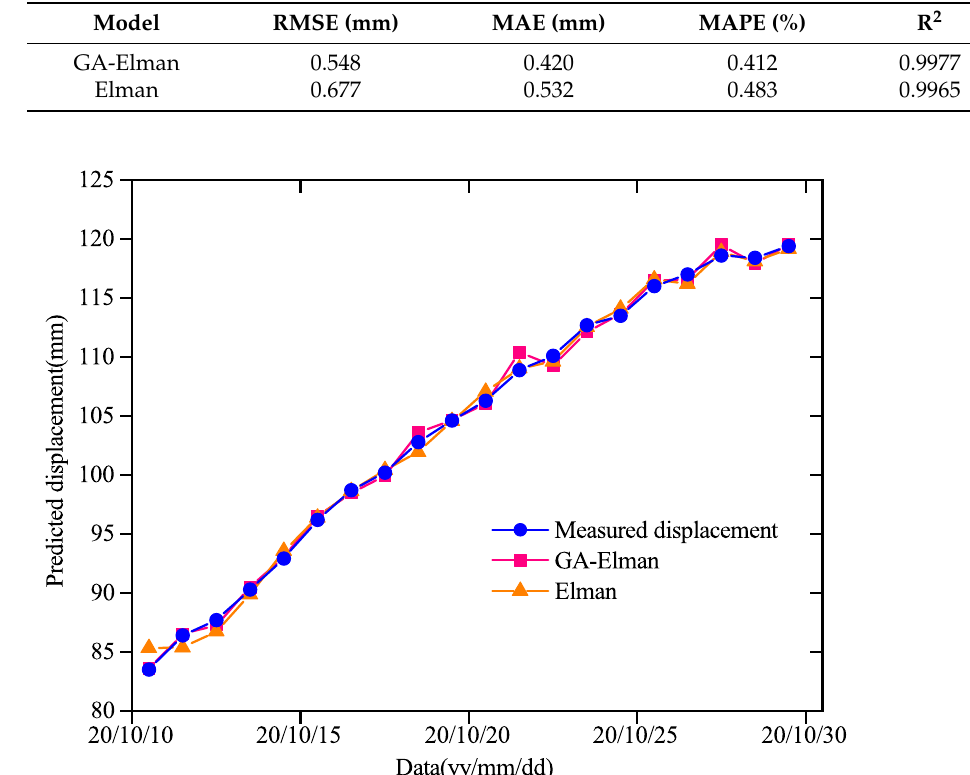
Figure 8. Comparison between prediction output and expectation